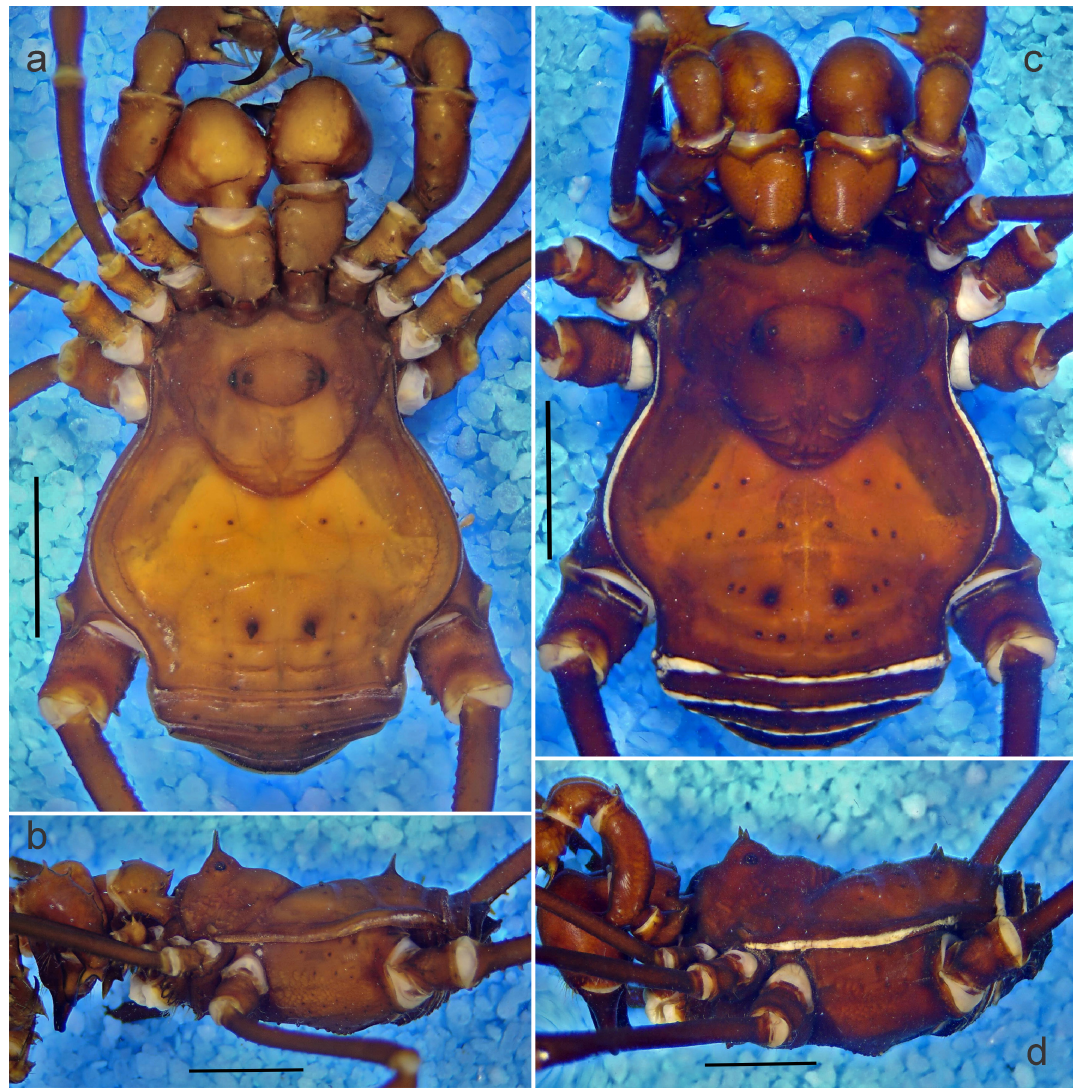
Fig. 8. — a–b . Phalangodus cottus sp. nov., holotpye, ♂ (MNRJ 8654). a . Habitus, dorsal view. b . Habitus, lateral view. — c–d . Phalangodus gyes sp. nov., holotype, ♂ (MNRJ 8655). c . Habitus, dorsal view. d . Habitus, lateral view. Scale bars = 5